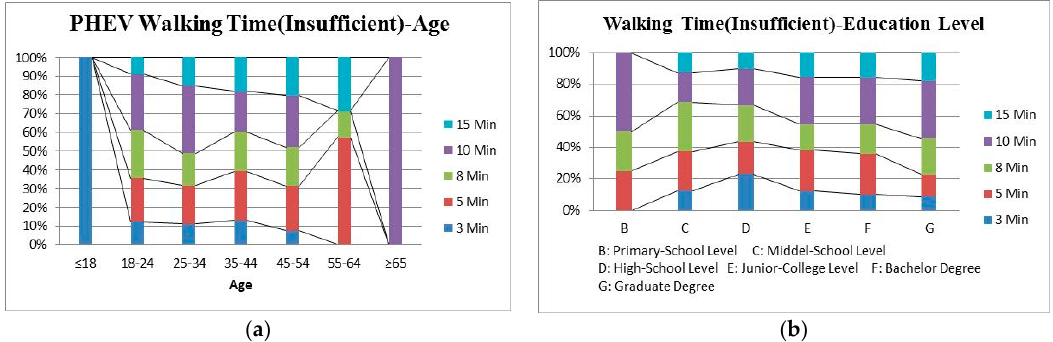
Figure A6. Relationship between walking time and significant variables for PHEV with insufficient charge: ( a ) Relationship between walking time and age; ( b ) Relationship between walking time and education level.